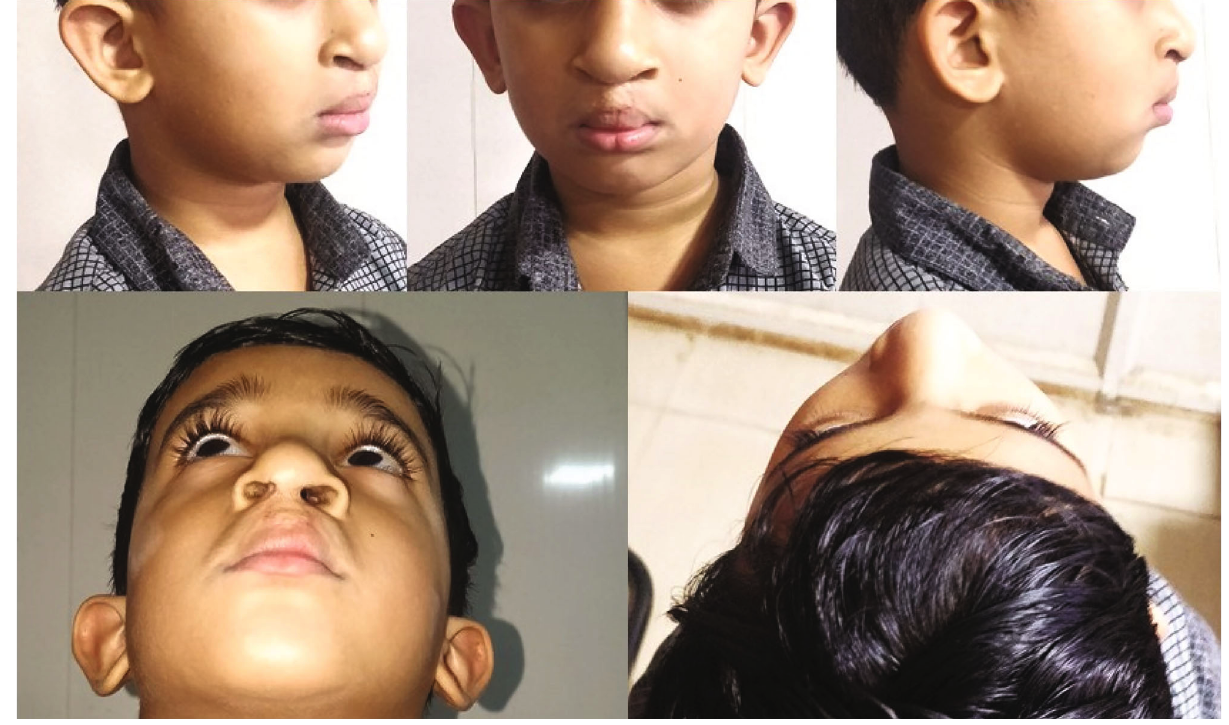
Figure 6: Four-year follow-up: